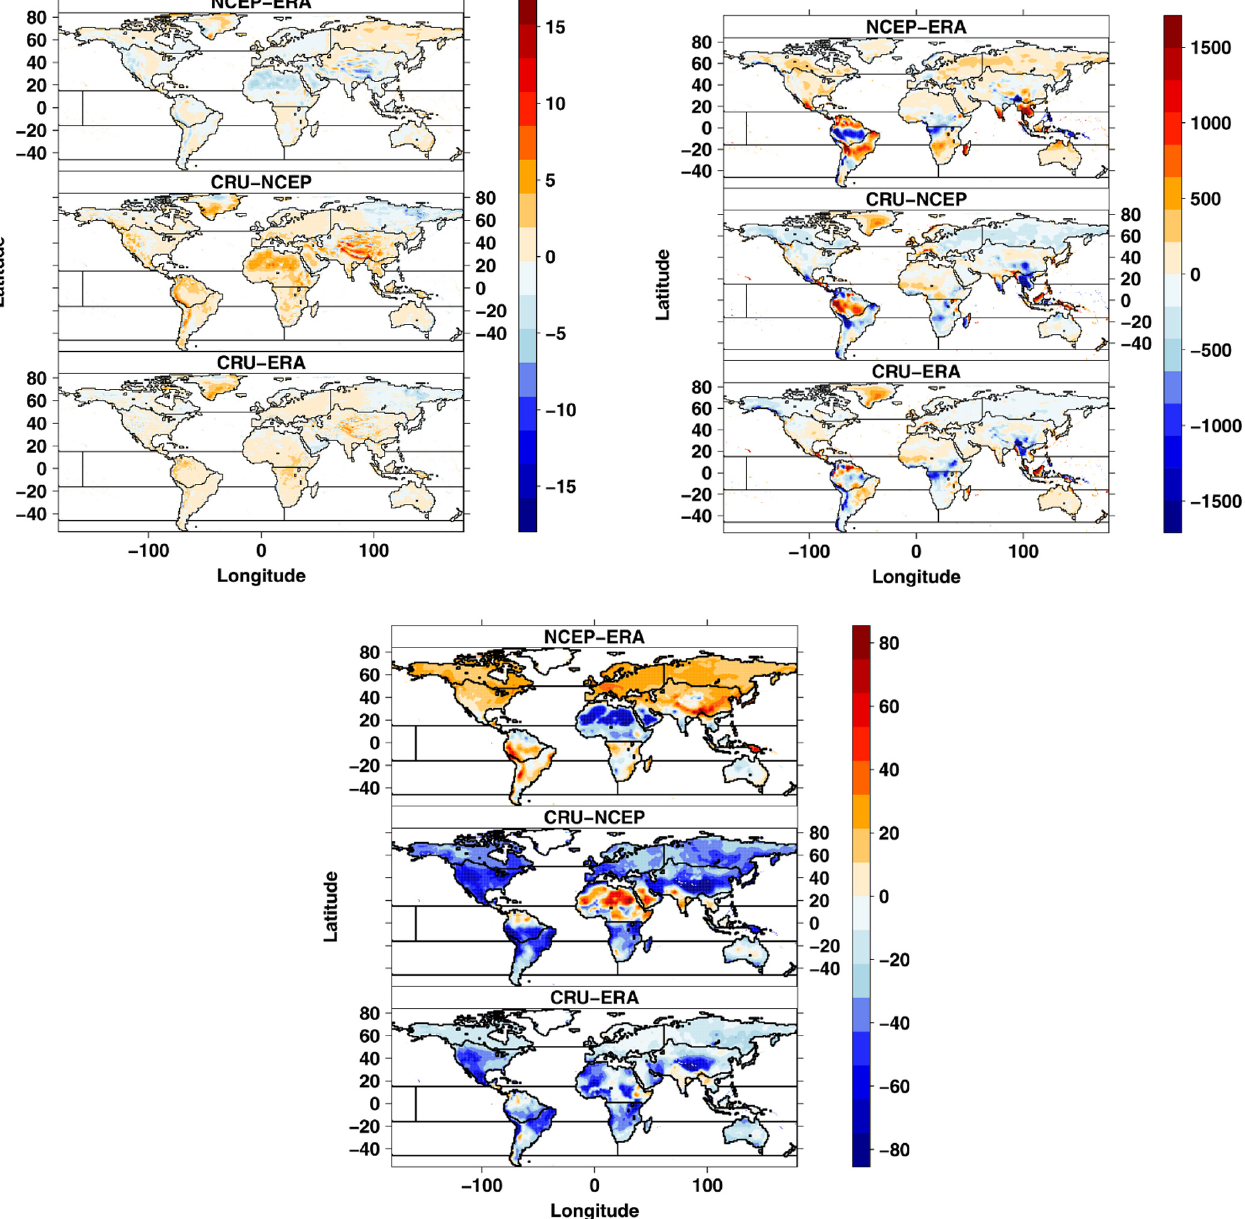
Fig. 1. (a) Spatial pattern of climate forcing differences between mean annual temperature, (b) total annual precipitation, and (c) downward shortwave